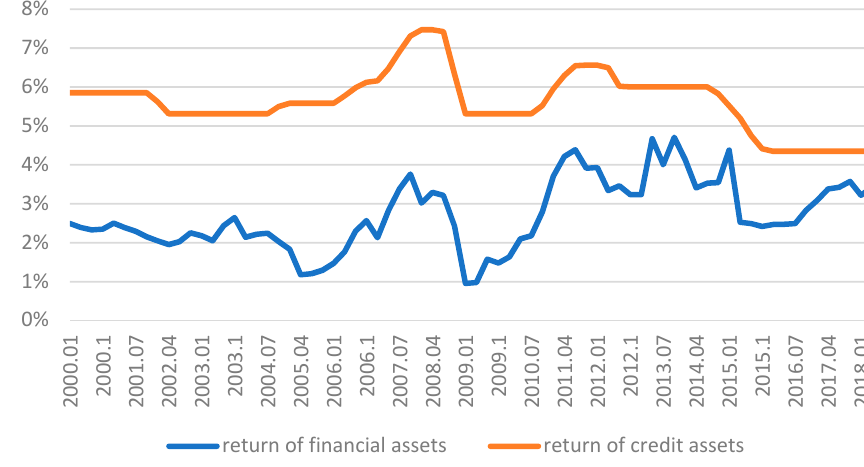
Figure 2. Yield curve of credit and financial assets.